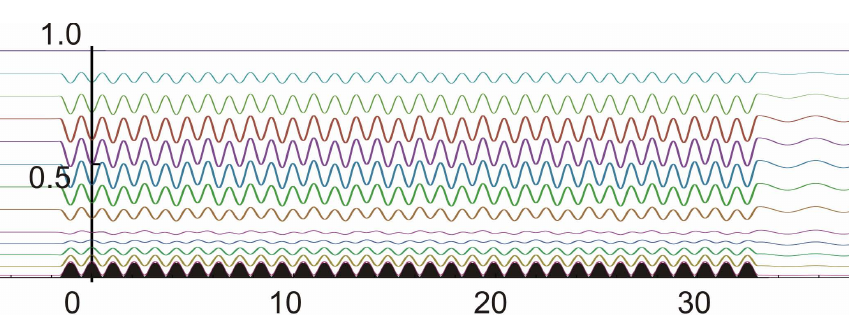
Fig. 5. Separation of wave zones over long sinusoidal topography: forced small-amplitude waves near the bottom ( y < 0 . 2) and slow modulated wave-train of moderate amplitude ( y > 0 .